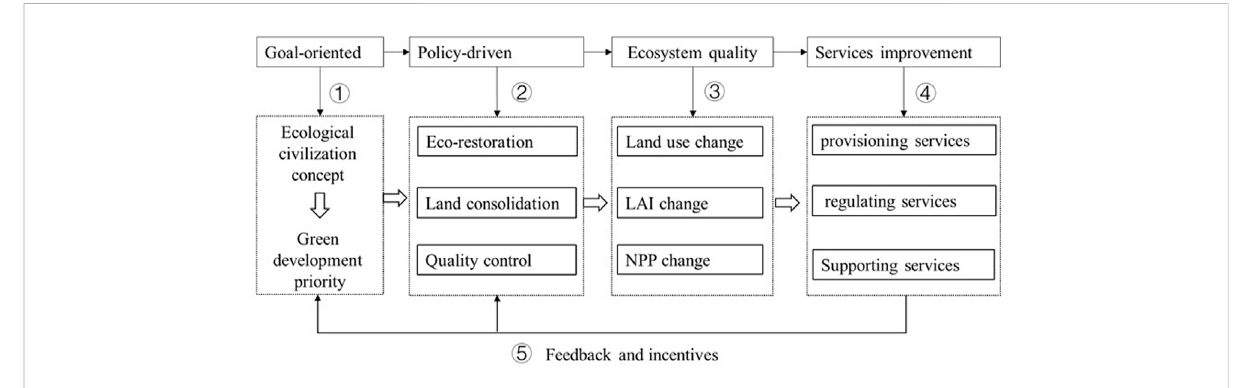
FIGURE 1 Driving framework of changes in ecological quality and ecosystem service